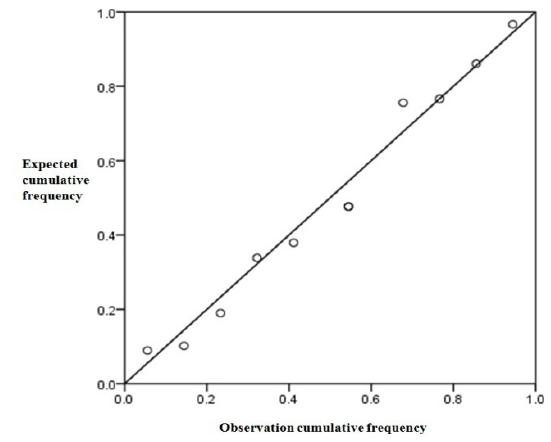
Fig.4. Normal distribution P-P